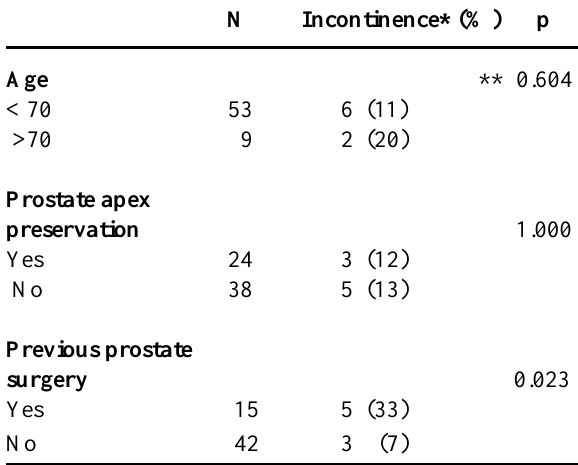
Table 1 - Risk factors and the incidence of daytime uri- nary incontinence. * More than one pad at daytime